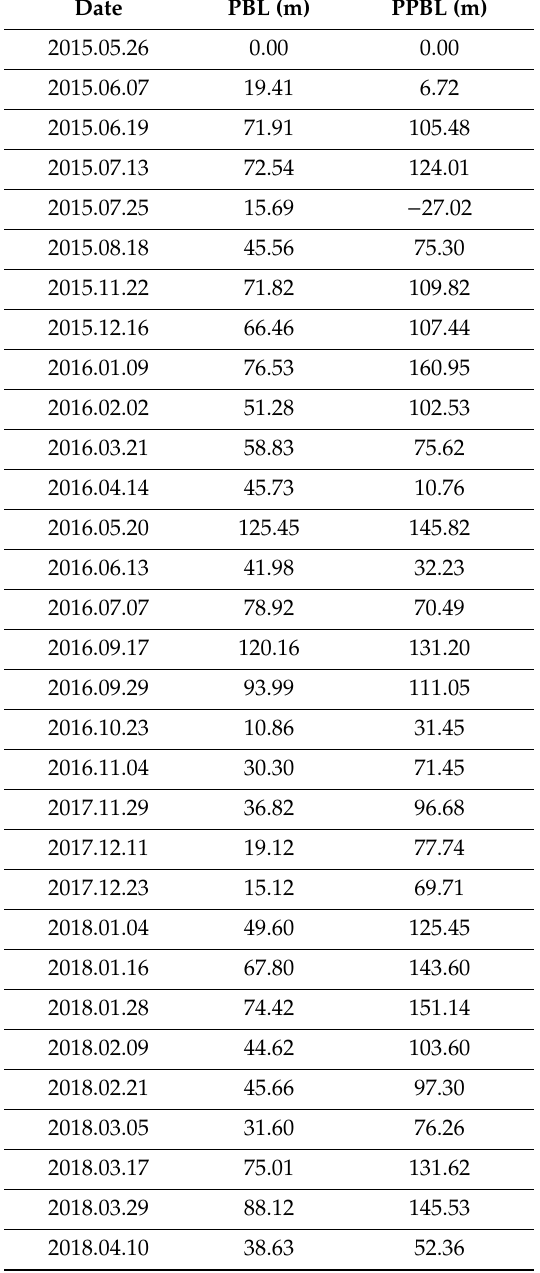
Table 1. List of Sentinel-1A images used in this study. PBL is the parallel baseline, and PPBL is the perpendicular baseline of the satellite in